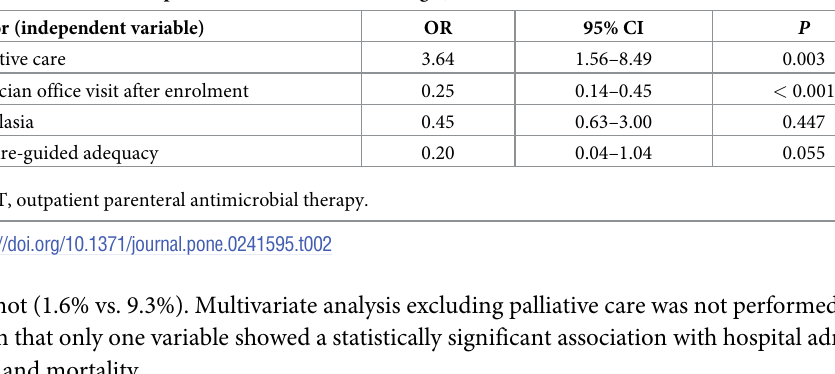
Table 2. Multivariate analysis of factors associated with hospital admission (independent variable) among patients enrolled in an outpatient parenteral antimicrobial therapy program at facilities within the Santa